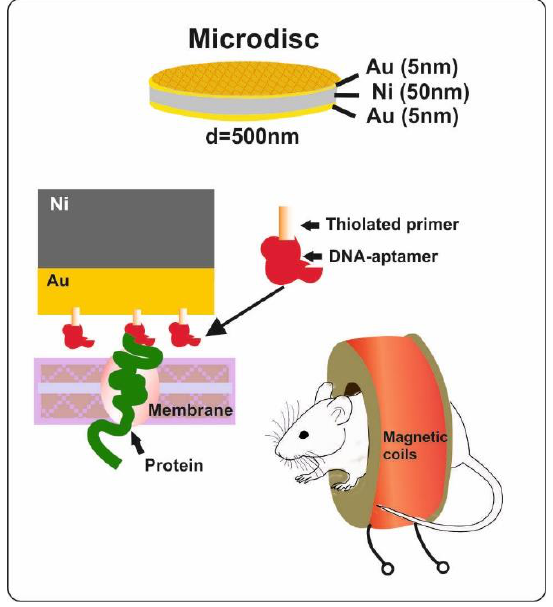
Figure 12. Au-Ni-Au magnetic microdisks with functional DNA bioaptamers used to destroy mouse cancer cells.